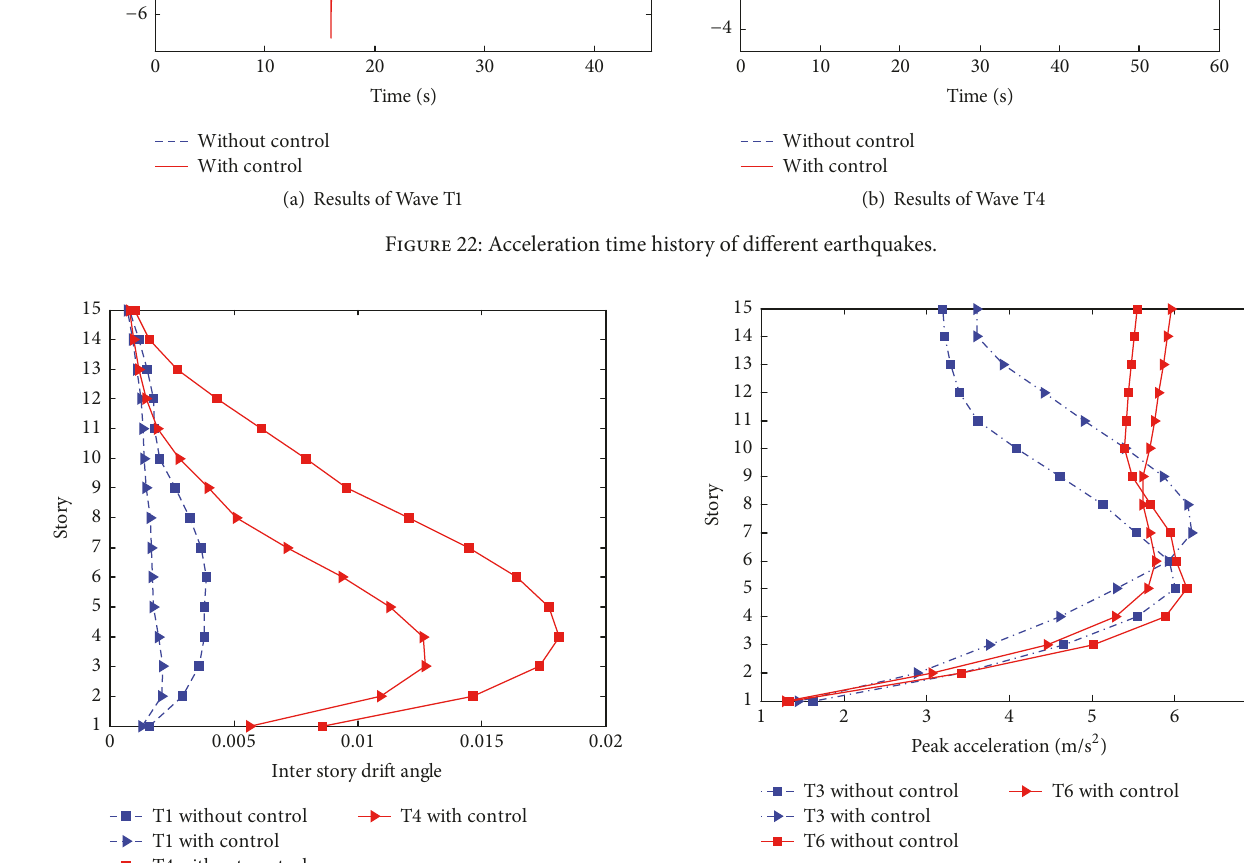
Figure 24: Peak acceleration before and after